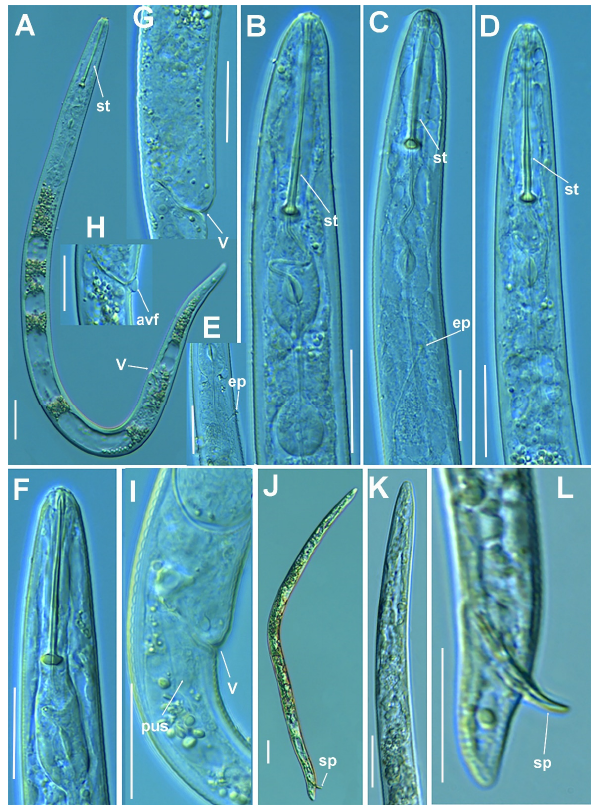
Figure 10. Micro-photomicrographs of Paratylenchus neonanus Mathur, Khan & Prasad, 1967 female and male. ( A ) Whole female with stylet and vulva arrowed; ( B–E ) Female pharyngeal region with stylet and excretory pore arrowed; ( F ) Female lip region; ( G–I ) Female posterior region with vulva and Postvulval uterine sac (arrowed) and detail of vulva showing advulval flap (arrowed); ( J ) Whole male; ( K ) Male pharyngeal region showing absence of stylet; ( L ) Male posterior region showing spicules (arrowed). Scale bars ( A–L = 20 µ m). (Abbreviations: avf = advulval flap; ep = excretory pore; lf = lateral field; pus = post-vulval uterine sac; sp = spicules; st = stylet; V =